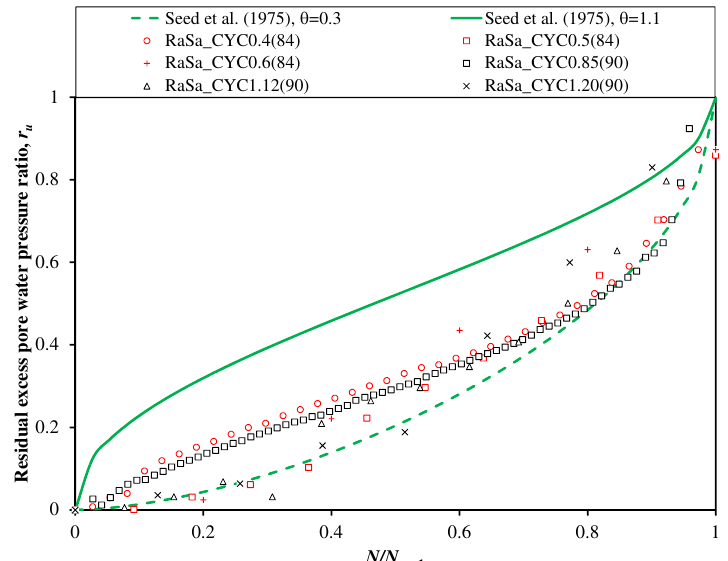
Fig. 8 Relationship between excess PWP ratio ( r u ) and the normalised number of cycles ( N ) by the number of cycles at